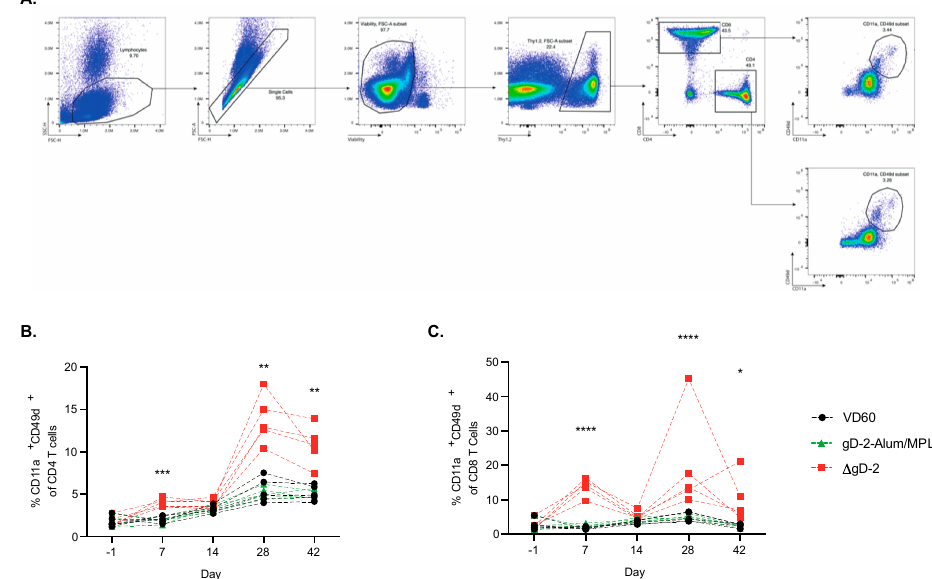
Figure 4. Kinetics of the T cell response following HSV vaccination. Female C57BL / 6 mice were vaccinated im twice, three weeks apart, with 5 × 10 5 pfu / mouse of ∆ gD-2 or 5 µ g gD-2 − Alum / MPL. Before vaccination (day 1) and at week 1 and 2 following prime and boost, mice were retro-orbitally bled and assessed for CD11a + CD49d + activatedCD4 and CD8 T cells. ( A ) The gating strategy is shown for the assessment of ( B ) CD4 and ( C ) CD8 T cell activation. Data was analyzed by mixed e ff ects analysis, * p < 0.5, ** p < 0.01, *** p < 0.001, **** p < 0.0001; n = 5 mice per group.